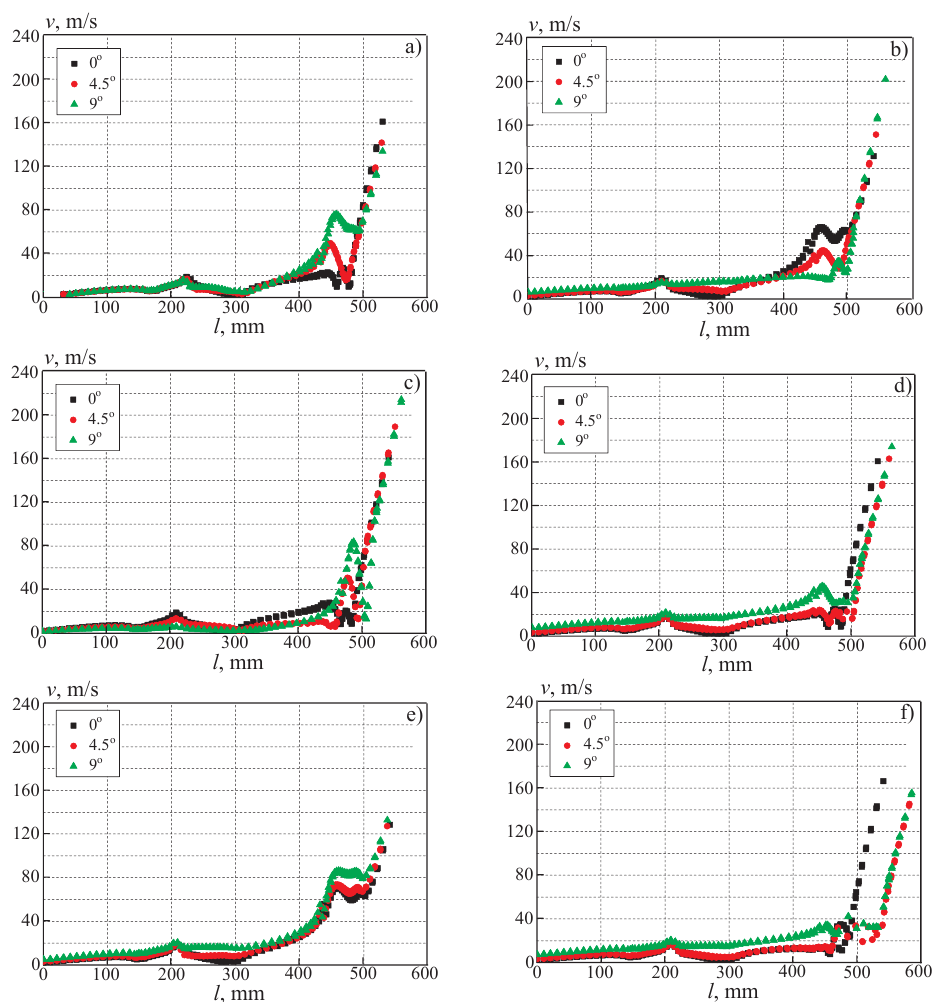
Figure 7. Velocity distributions along nozzle surface in control points A – F ( a – f ) for various angles of nozzle rotation for cylindrical channel.